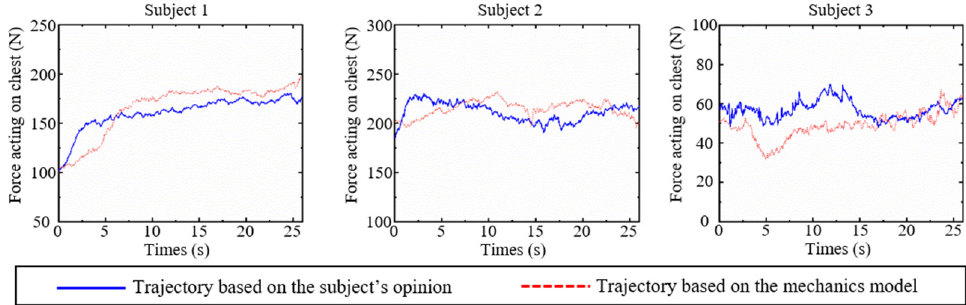
Figure 9. The force acting on the chest of three subjects in different motions.